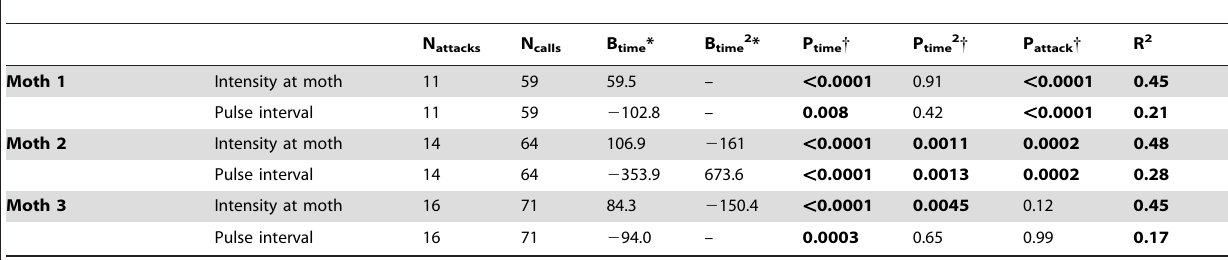
Table 2. Myotis call intensities and pulse intervals with respect to time before clicking for three Bertholdia trigona